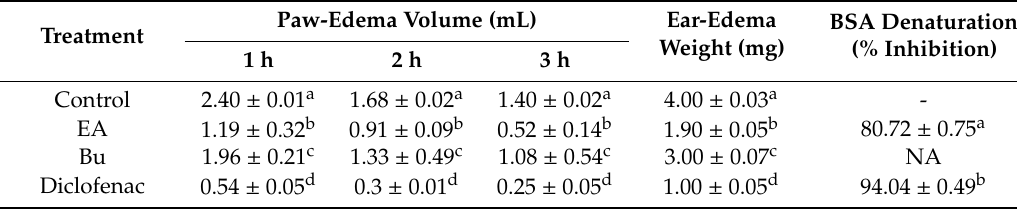
Table 2. Anti-inflammatory activities of S. tenuipes